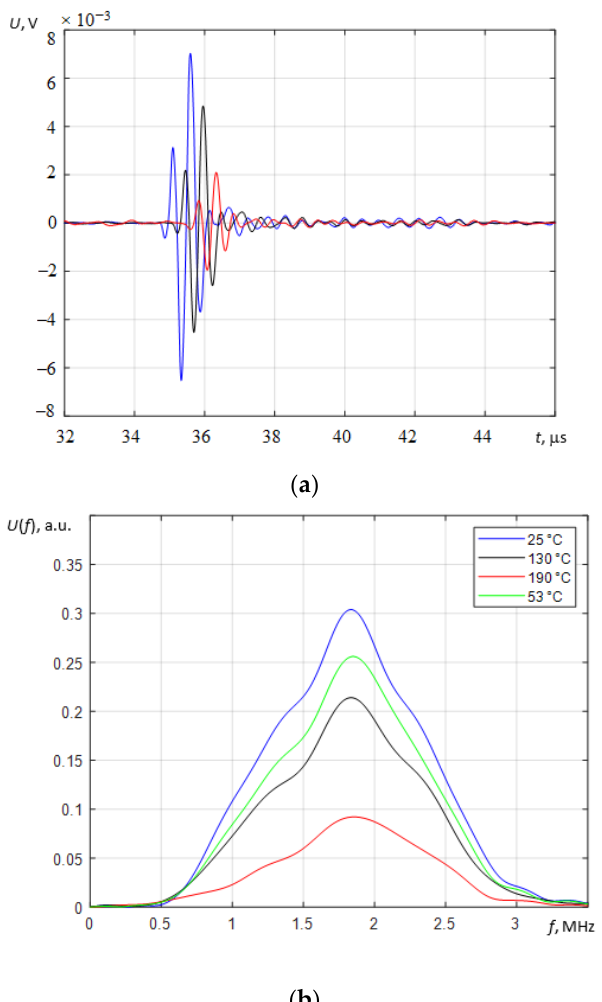
Figure 8. The reflected signals from the bottom of the test sample ( a ) and their spectra ( b ) at different temperatures of the sample. Blue: 25 °C; black: 130 °C; red: 190 °C; green: 53 °C (during cooling).